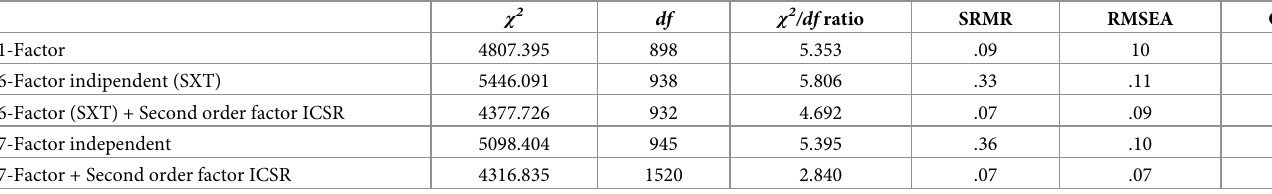
Table 2. Results of confirmatory factor